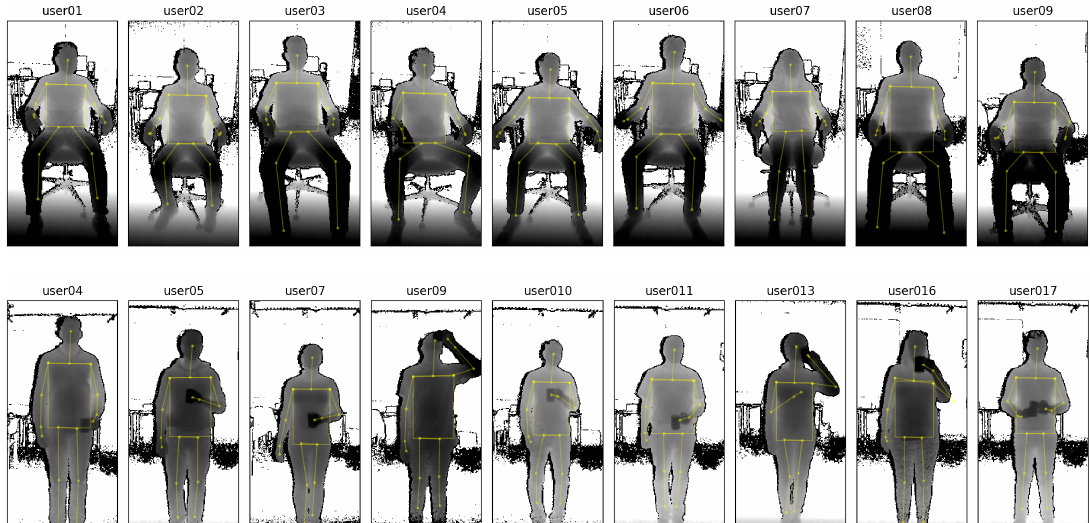
Figure 6. In our evaluations, 24 study participants (of which 7 female, aged between 22 and 57 years old) were asked to sit or stand in front of a depth sensor and were recorded for different conditions. Top row : Exemplary depth data from some participants while sitting. Bottom row : Some examples of participants while holding a cup (leading to regular occlusions of the torso). All of the above examples are taken from 2 metres distance